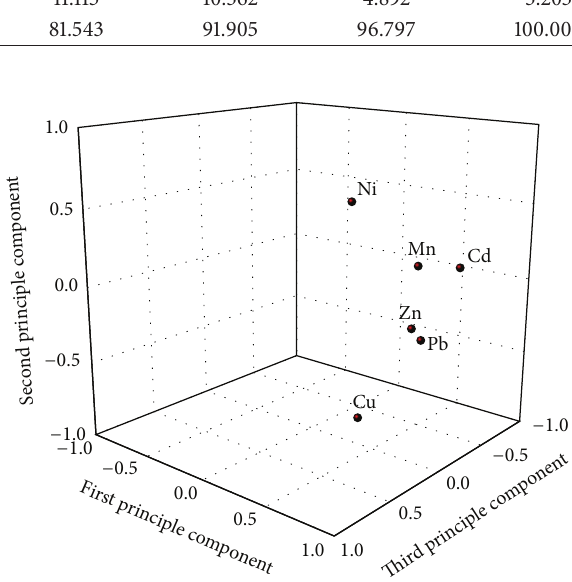
Figure 3: Scree plot.